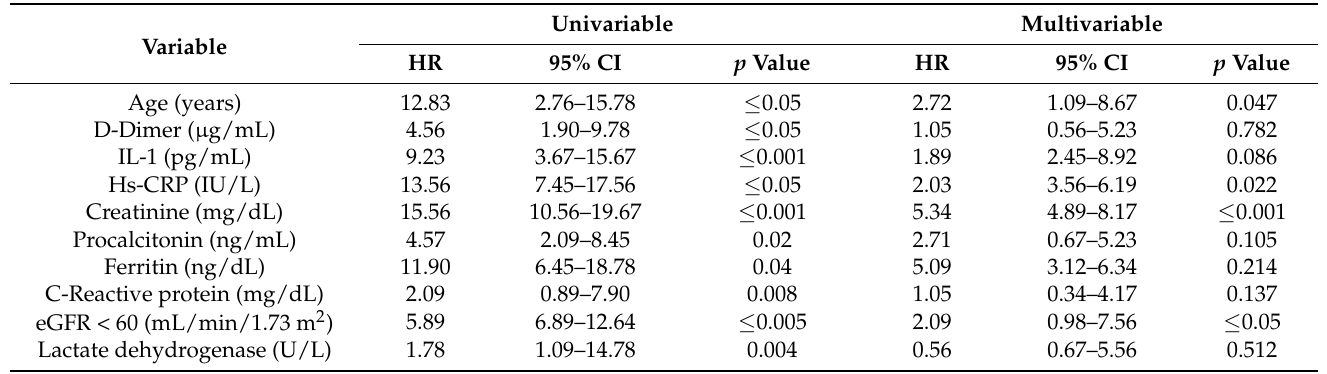
Table 4. Cox proportional hazard analysis to identify risk factors for in-hospital